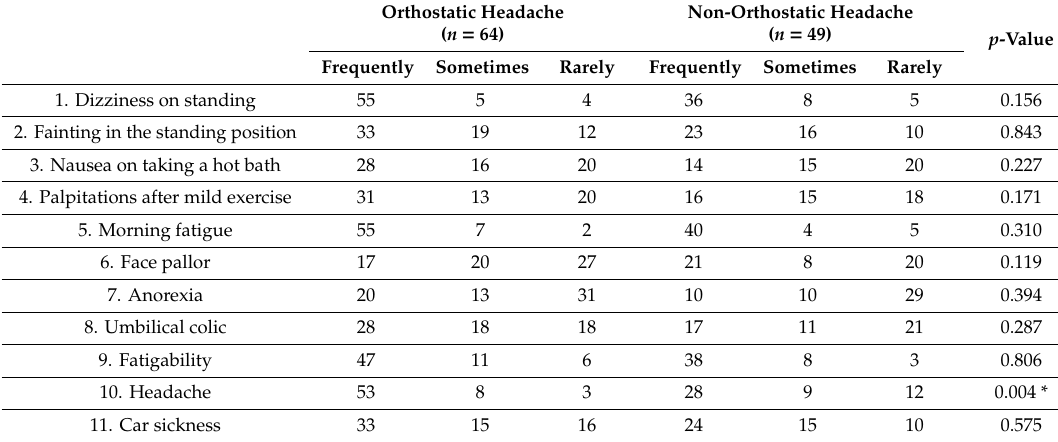
Table 2. Daily physical